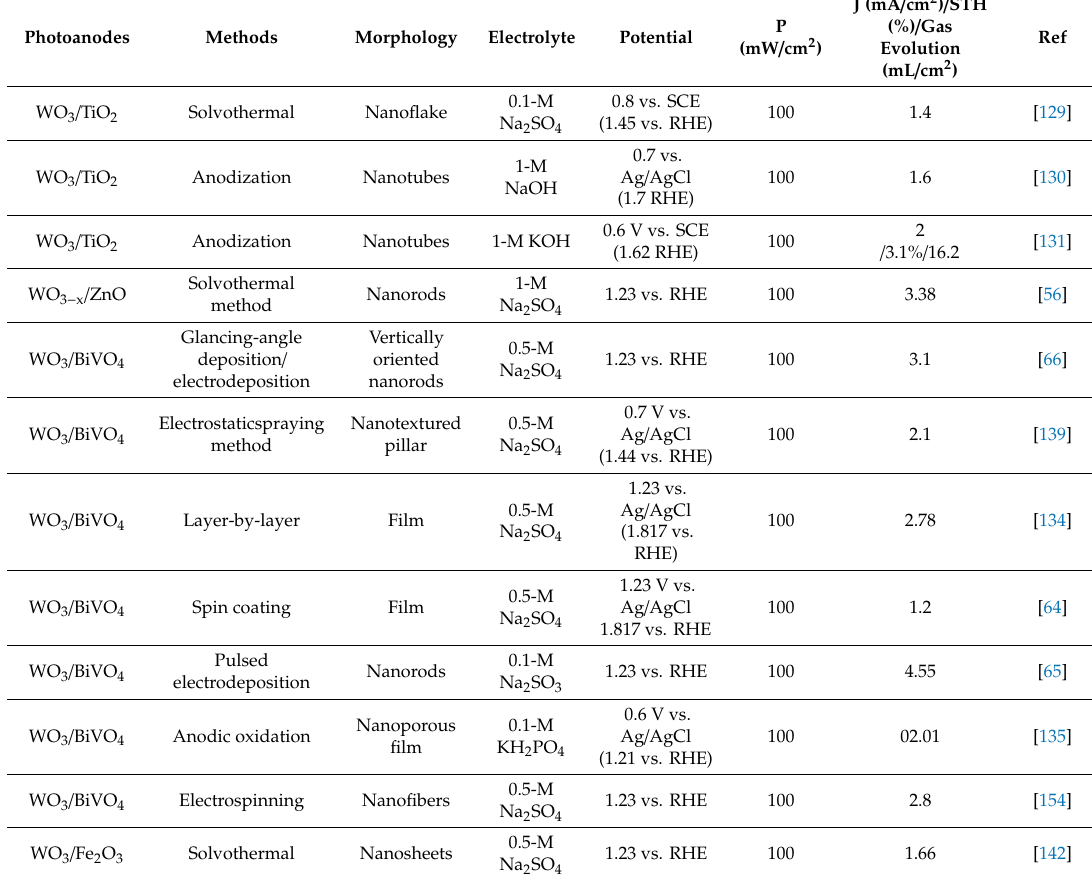
Figure 13. ( a ) Current -potential curves of WO 3 @Au composite with HAuCl 4 concentrations of 8, 24 and 240 umol in 0.1-M Na 2 SO 4 electrolyte and ( b ) SEM images of WO 3 @Au composites. Reproduced from ref [149] with permission from Springer Nature, 2016. Table 1. Photocurrent densities of binary